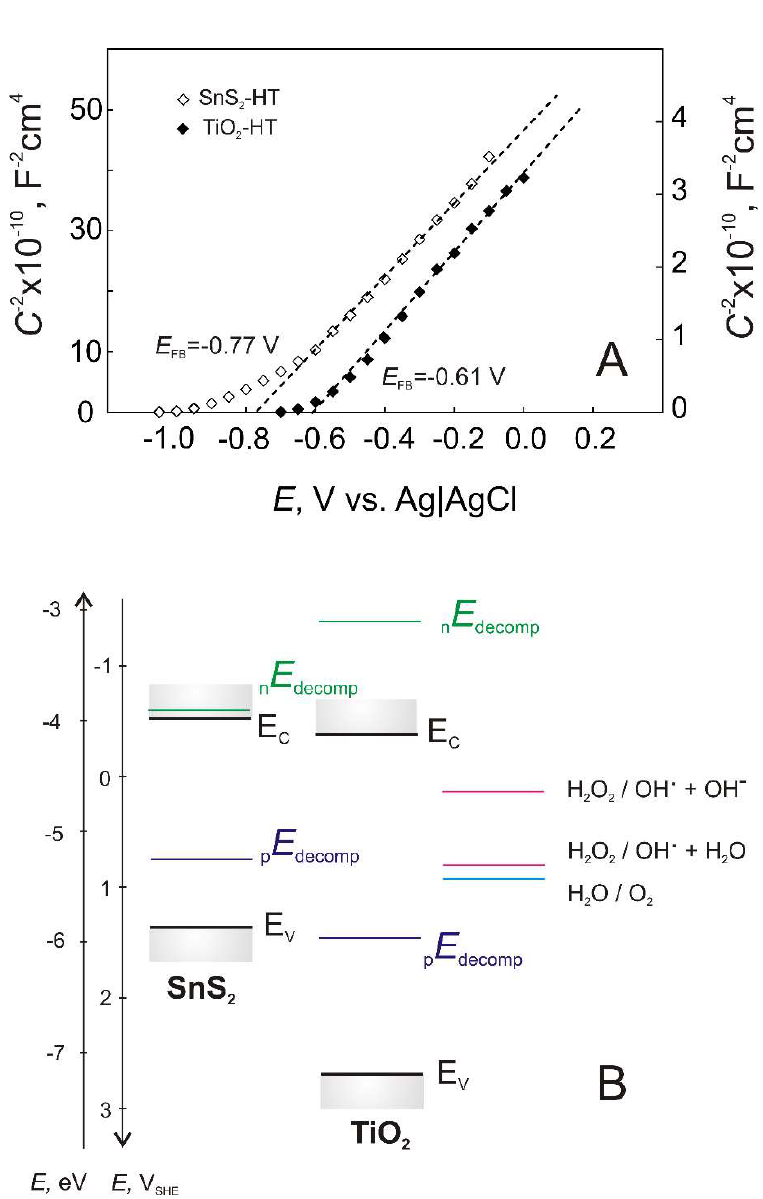
Figure 6. Mott–Schottky plots of the TiO 2 -HT and SnS 2 -HT films recorded in NaCl solution ( A ). The energy band diagram for TiO 2 and SnS 2 catalyst films ( B ).